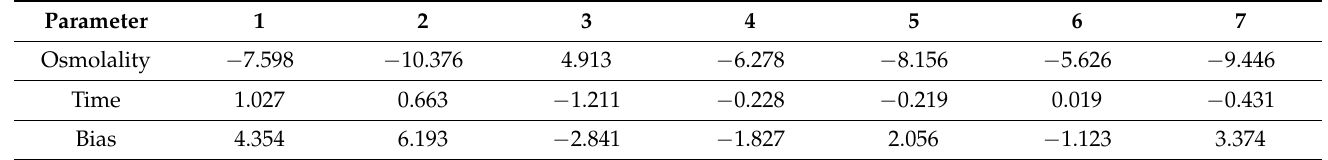
Table 6. The weight coefficients and biases: W 1 and B 1 , respectively.